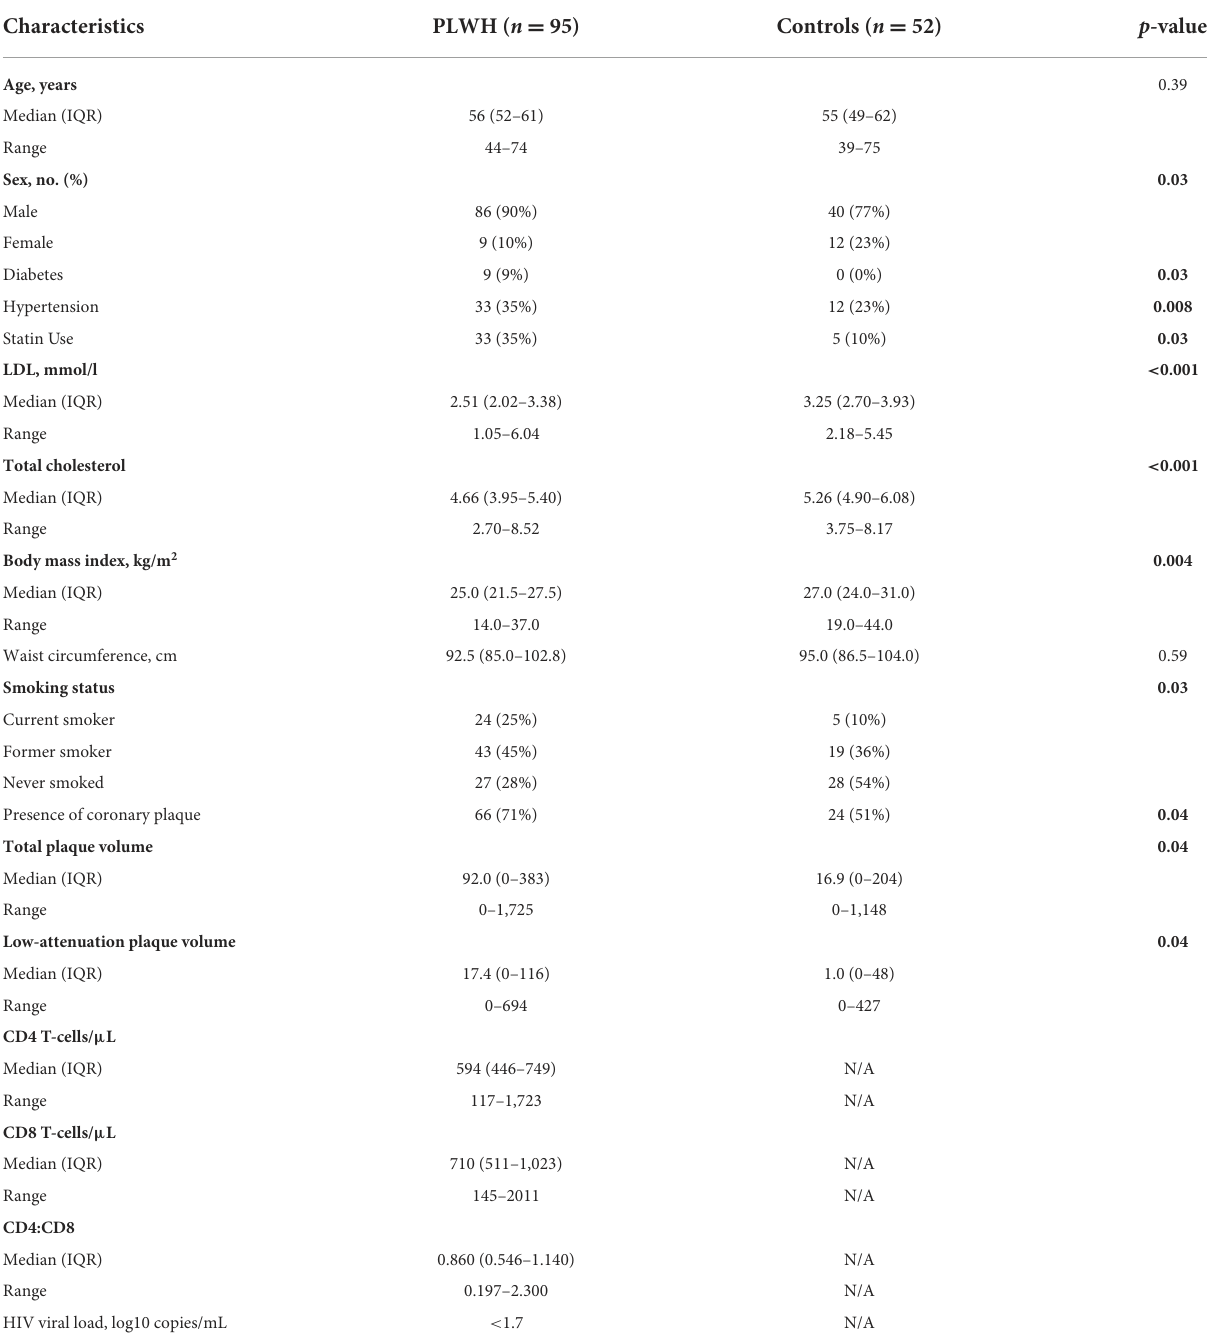
TABLE 1 Clinical characteristics of study participants ( n =